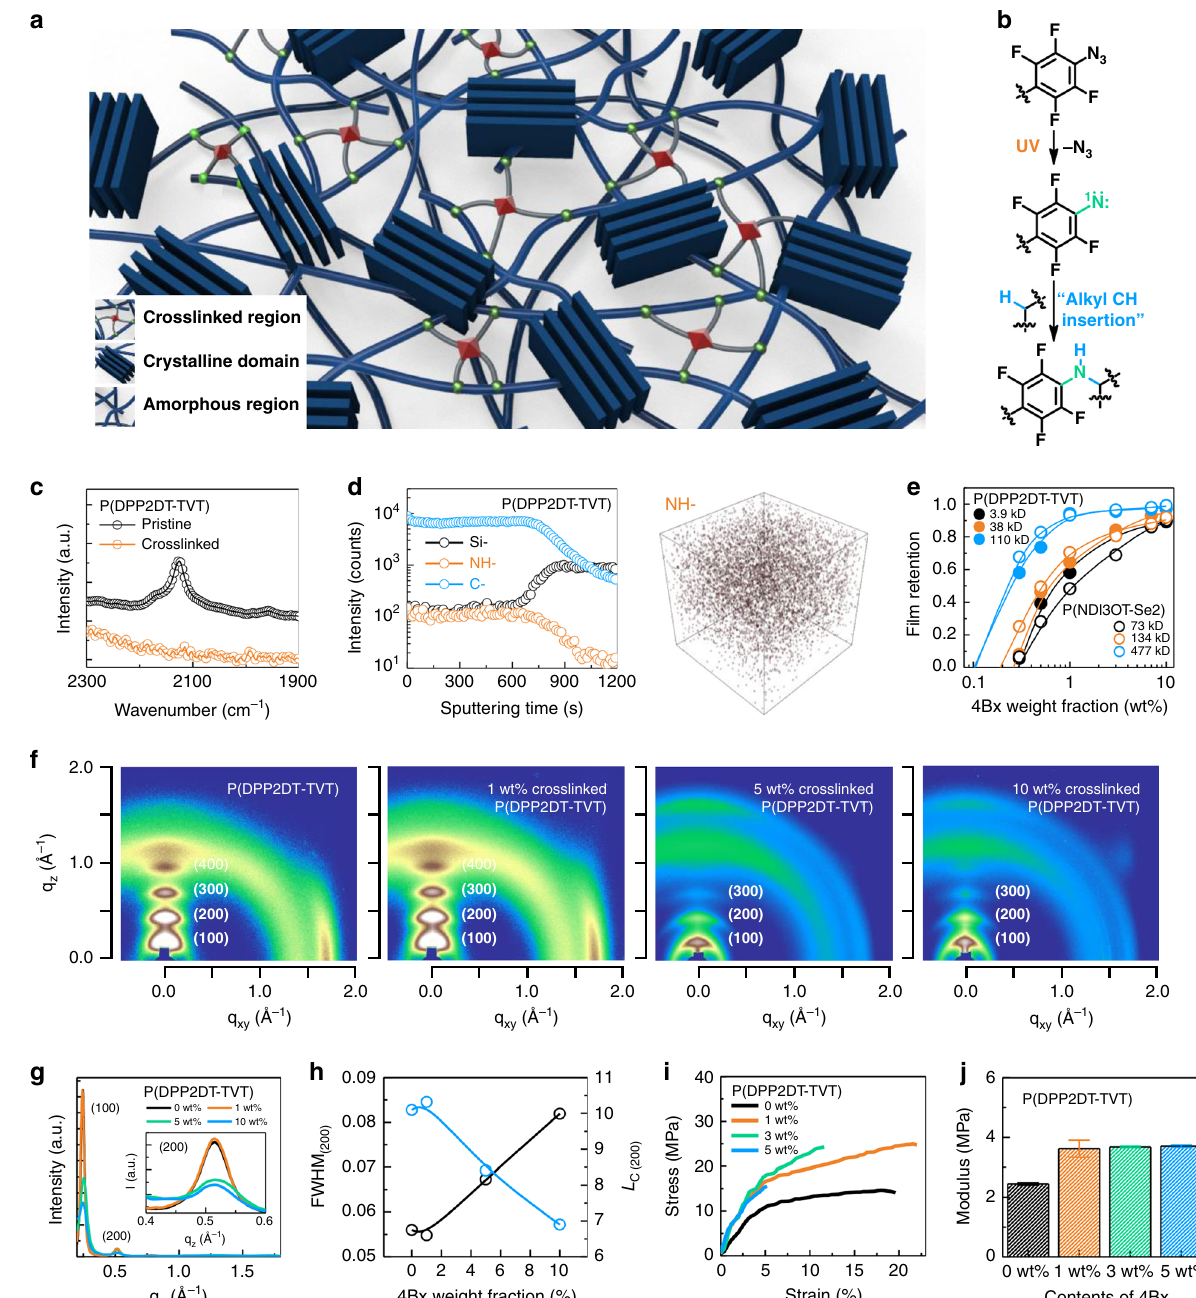
Fig. 2 Structural characterization of crosslinked P(DPP2DT-TVT). a Schematic illustration of a semiconducting polymer in its crosslinked state formed by 4Bx. b The key chemical reaction involved for the crosslinking. c FTIR spectra of P(DPP2DT-TVT) fi lms before and after being crosslinked. d TOF-SIMS spectra of crosslinked P(DPP2DT-TVT) fi lm monitored as a function of sputtering time. e Film retention characteristics of P(DPP2DT-TVT) and P(NDI3OT- Se2) formed with different contents of 4Bx. f 2D GIXD patterns of a series of P(DPP2DT-TVT) fi lms using different loadings of 4Bx. g The line-cut diffraction pro fi les of the diffractograms for P(DPP2DT-TVT) fi lms along the of out-of-plane direction. The inset is an enlarged view of the plot near the (200) peak. h Summary of FWHM and characteristic coherence length ( L C ) of the out-of-plane (200) peak for P(DPP2DT-TVT) fi lms crosslinked using different loadings of 4Bx. i The stress – strain curves of a series of P(DPP2DT-TVT) fi lms crosslinked using different loadings of 4Bx (0, 1, 3, and 5 wt%). j Tensile modulus of a series of P(DPP2DT-TVT) fi lms crosslinked using different loadings of 4Bx (0, 1, 3, and 5